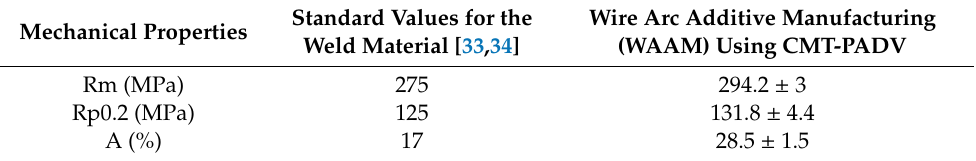
Table 3. Mechanical properties of the weld material and the tested specimen